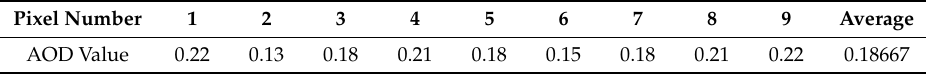
Table 4. Inversion AOD (aerosol optical depth) of selected points.